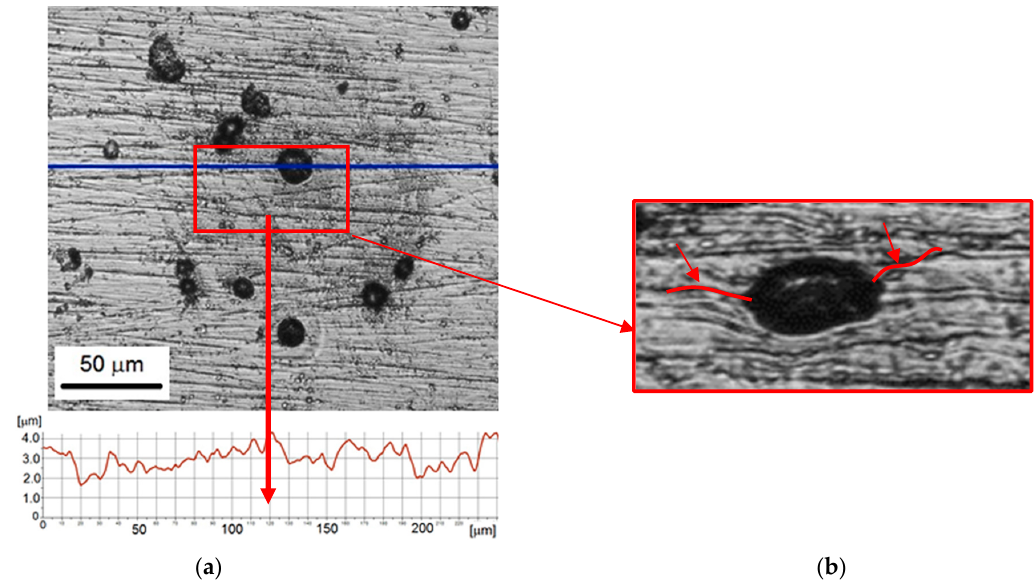
Figure 6. Nickel coating after 5 min of the cavitation erosion tests: ( a ) surface morphology with roughness profile along the selected measurement line; ( b ) 3D surface profile of a pit.